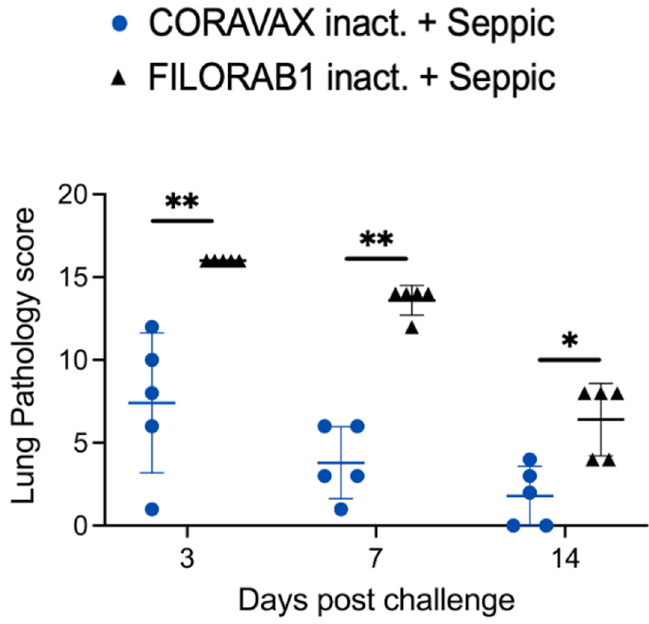
Figure 7. Comparative pathology scores for lungs from CORAVAX-vaccinated and control ham- sters post-SARS-CoV-2 challenge. Overall lung pathology scores on days 3, 7, and 14 days p.c. The pathology scores (mean) were calculated based on the criteria described in Table S1. The CORAVAX vaccine group is shown in blue circles, and the FILORAB1 control group is in black triangles. Data represent mean ± S.D., n = 5 for FILORAB1 group and CORAVAX group for days 3, 7, and 15 time points; p > 0.123 (ns), p < 0.033 (*), p < 0.002 (**), p < 0.001 (***). Only significant differences are de- picted.